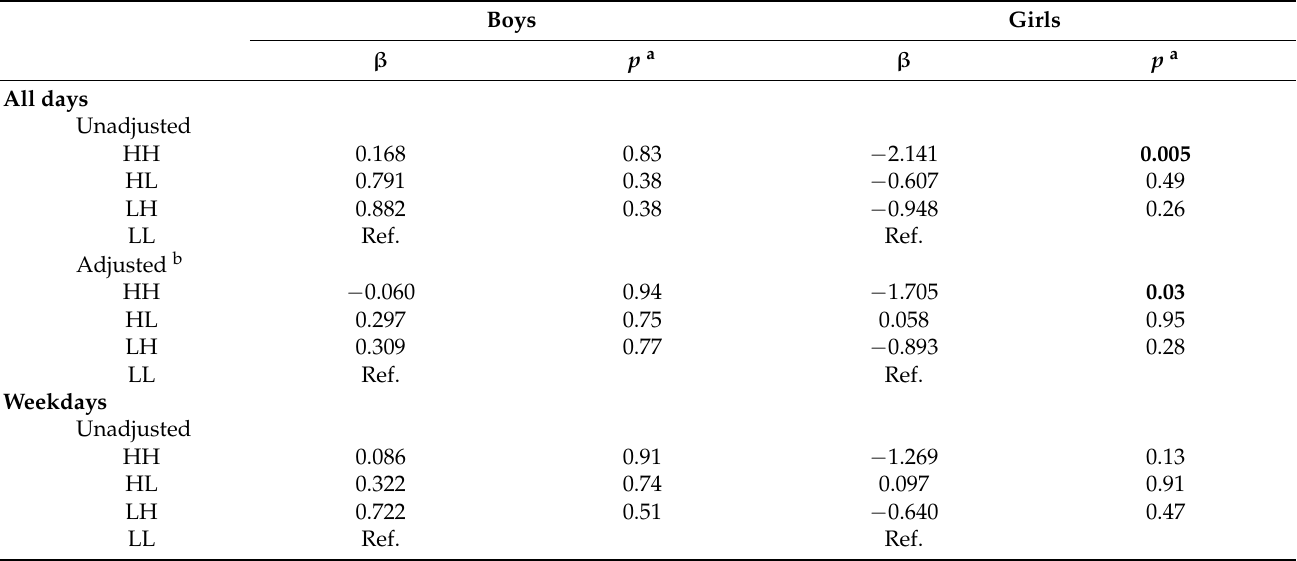
Table 4. Categorical total daily screen time from age 15 to 17 versus age 17 body